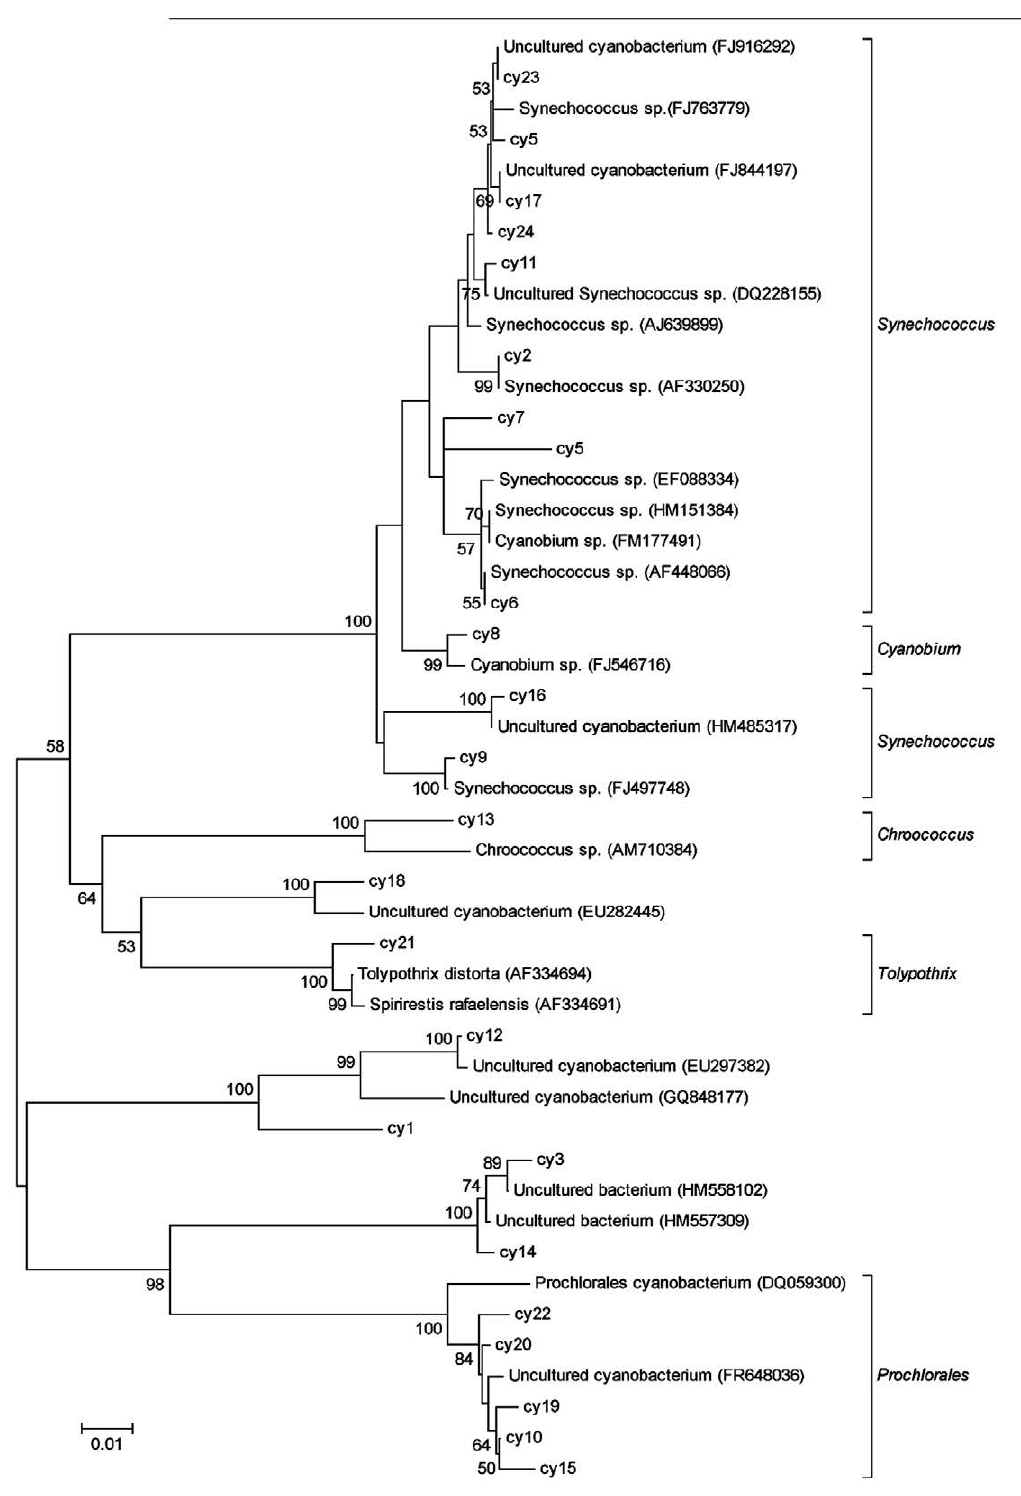
Fig. 7. – Phylogenetic tree based on 16S rRNA gene sequences representing the respective DGGE bands in Figure 3. Bootstrap analysis was based on 1000 replicates. Bootstrap values from distance analysis are depicted. Bootstrap values lower than 50% are not